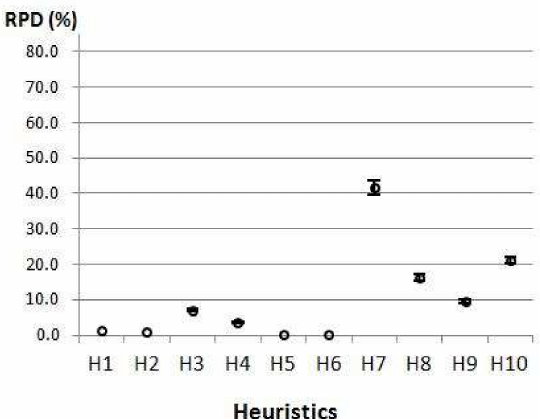
Figure 3. Comparisons of performances of heuristics in relation to those of model (95% confidence intervals of average RPD).